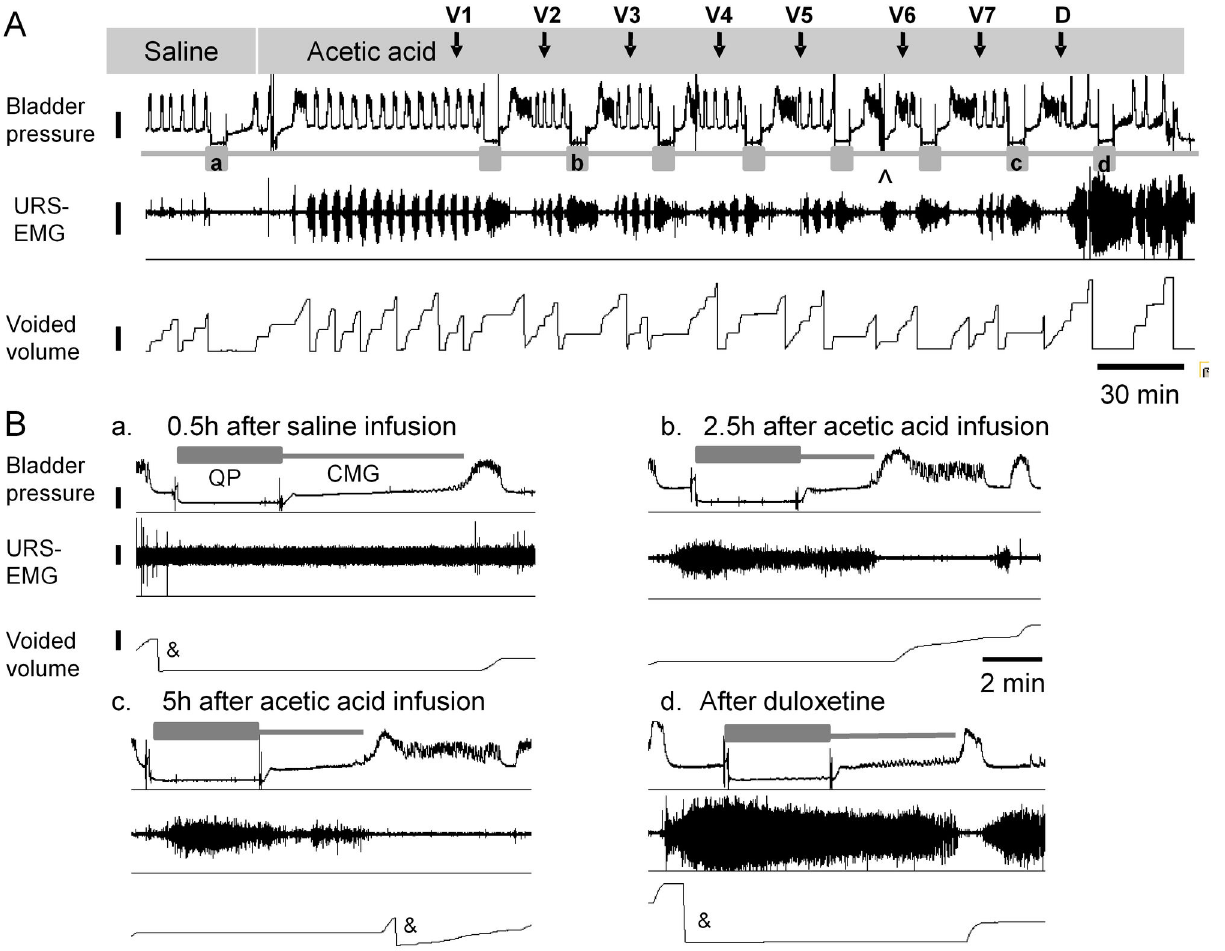
Figure 2. Typical recording traces. A. Bladder pressure, URS-EMG activity and voided volume recorded while bladder was infused with saline followed by acetic acid. Grey boxes underneath bladder pressure trace indicate quiet periods. Letters inside grey boxes correspond to insets enlarged in B. Calibration bars are 10 mmHg for bladder pressure, 1 µV for URS-EMG activity, 2 ml for voided volume and 30 min for time